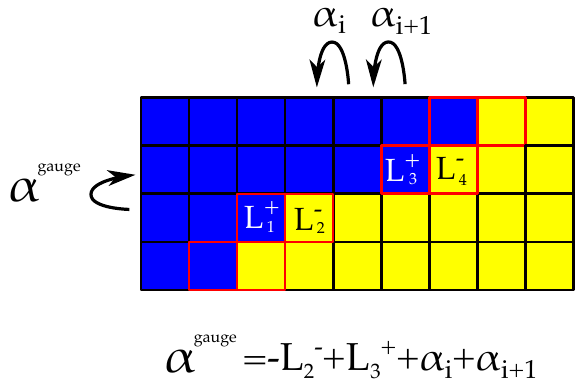
Figure 25. Example box graph for SU( n ) gauge (cid:2) U( m ) BG : the root (cid:11) gauge of the gauge algebra SU( n ) splits. The extremal weights are boxed in red. The splitting of (cid:11) gauge into the extremal weights L (cid:0) and L + , as well as the roots of G BG , (cid:11) i , is determined from the box graph. The arrows 2 3 indicate, as usual for box graphs, addition of roots. In the geometry, we associate to (cid:11) gauge the curves f i and to (cid:11) j the curves F j